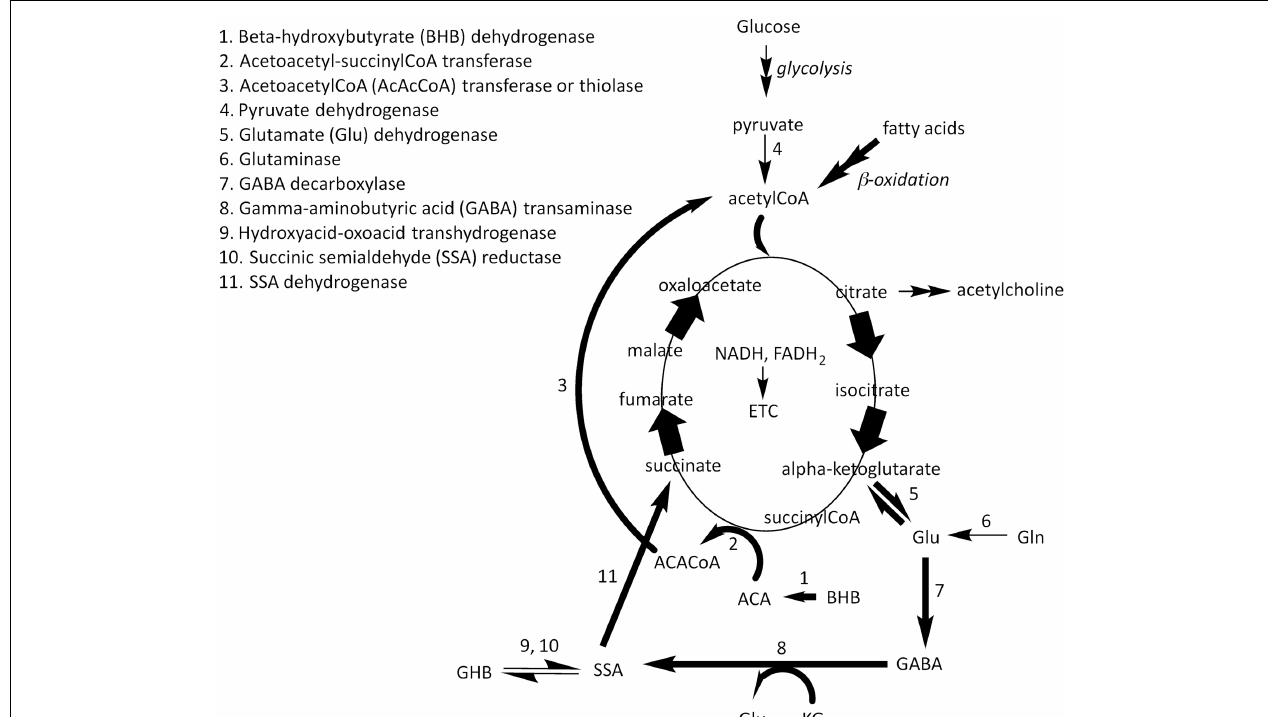
FIGURE 1 | β -hydroxybutyrate andACA are utilized as fuel molecules in all mitochondria-containing tissues (except liver) . BHB is oxidized to ACA by β -hydroxybutyrate dehydrogenase at the inner mitochondrial membrane (arrow 1). ACA acquires the CoA moiety from succinylCoA resulting in succinate and acetoacetylCoA (ACACoA; arrow 2). ACACoA releases acetylCoA catalyzed by ACACoA thiolase (arrow 3). AcetylCoA generated from β -oxidation of fatty acids from the diet and acetylCoA generated by the catabolism of KB is condensed into citrate in the Krebs cycle.The increased flux in the right part of this cycle, increases the concentration of α -ketoglutarate (KG) resulting in increases in the production of Glu via glutamate dehydrogenase (arrow 5) or a transaminase (not shown). Glu